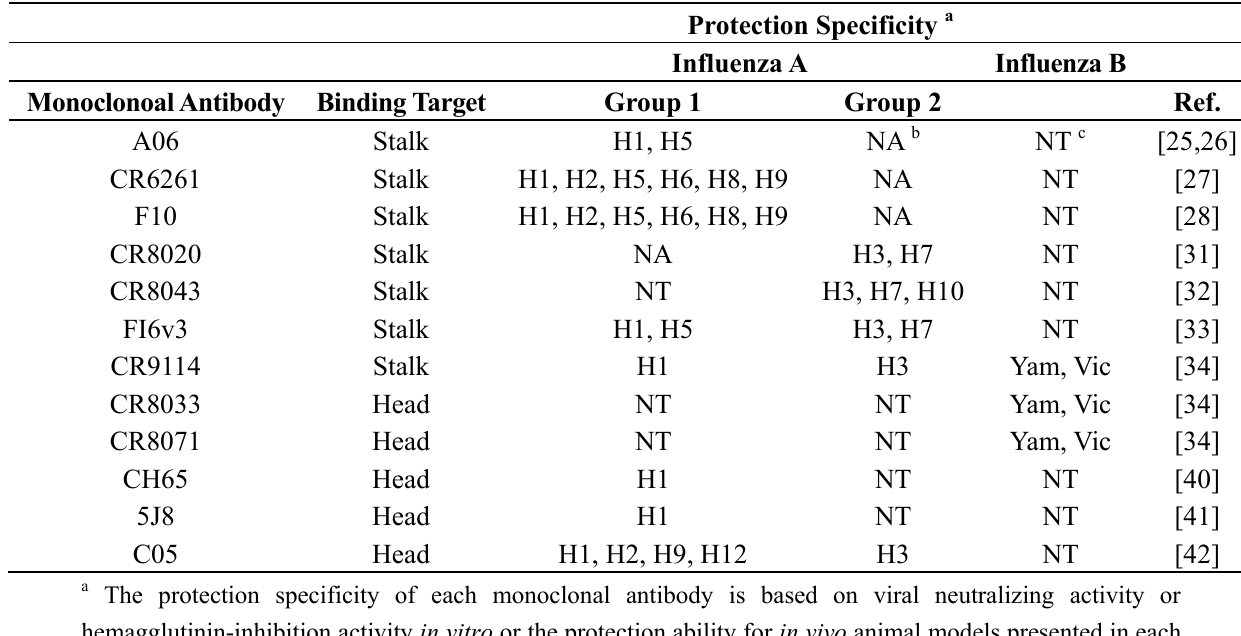
Table 1. Selected human broadly neutralizing monoclonal antibodies specific to